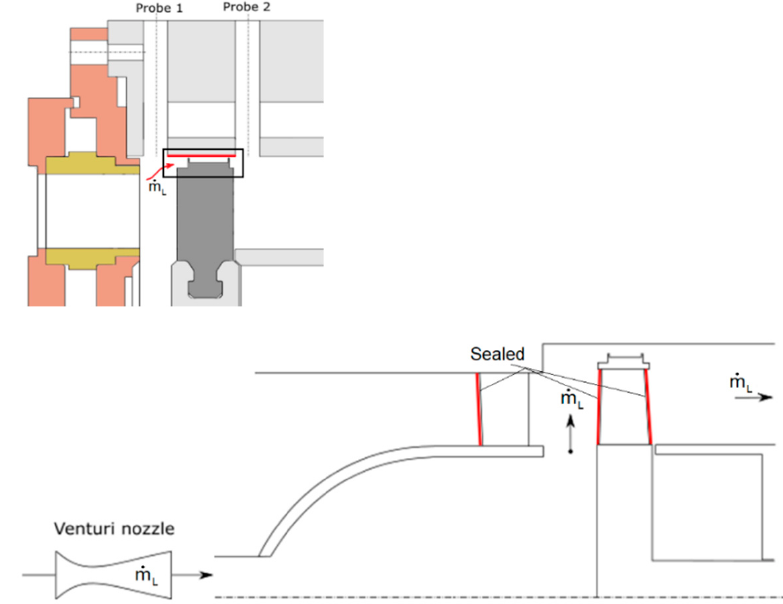
Figure 8. Tip leakage calibration scheme.